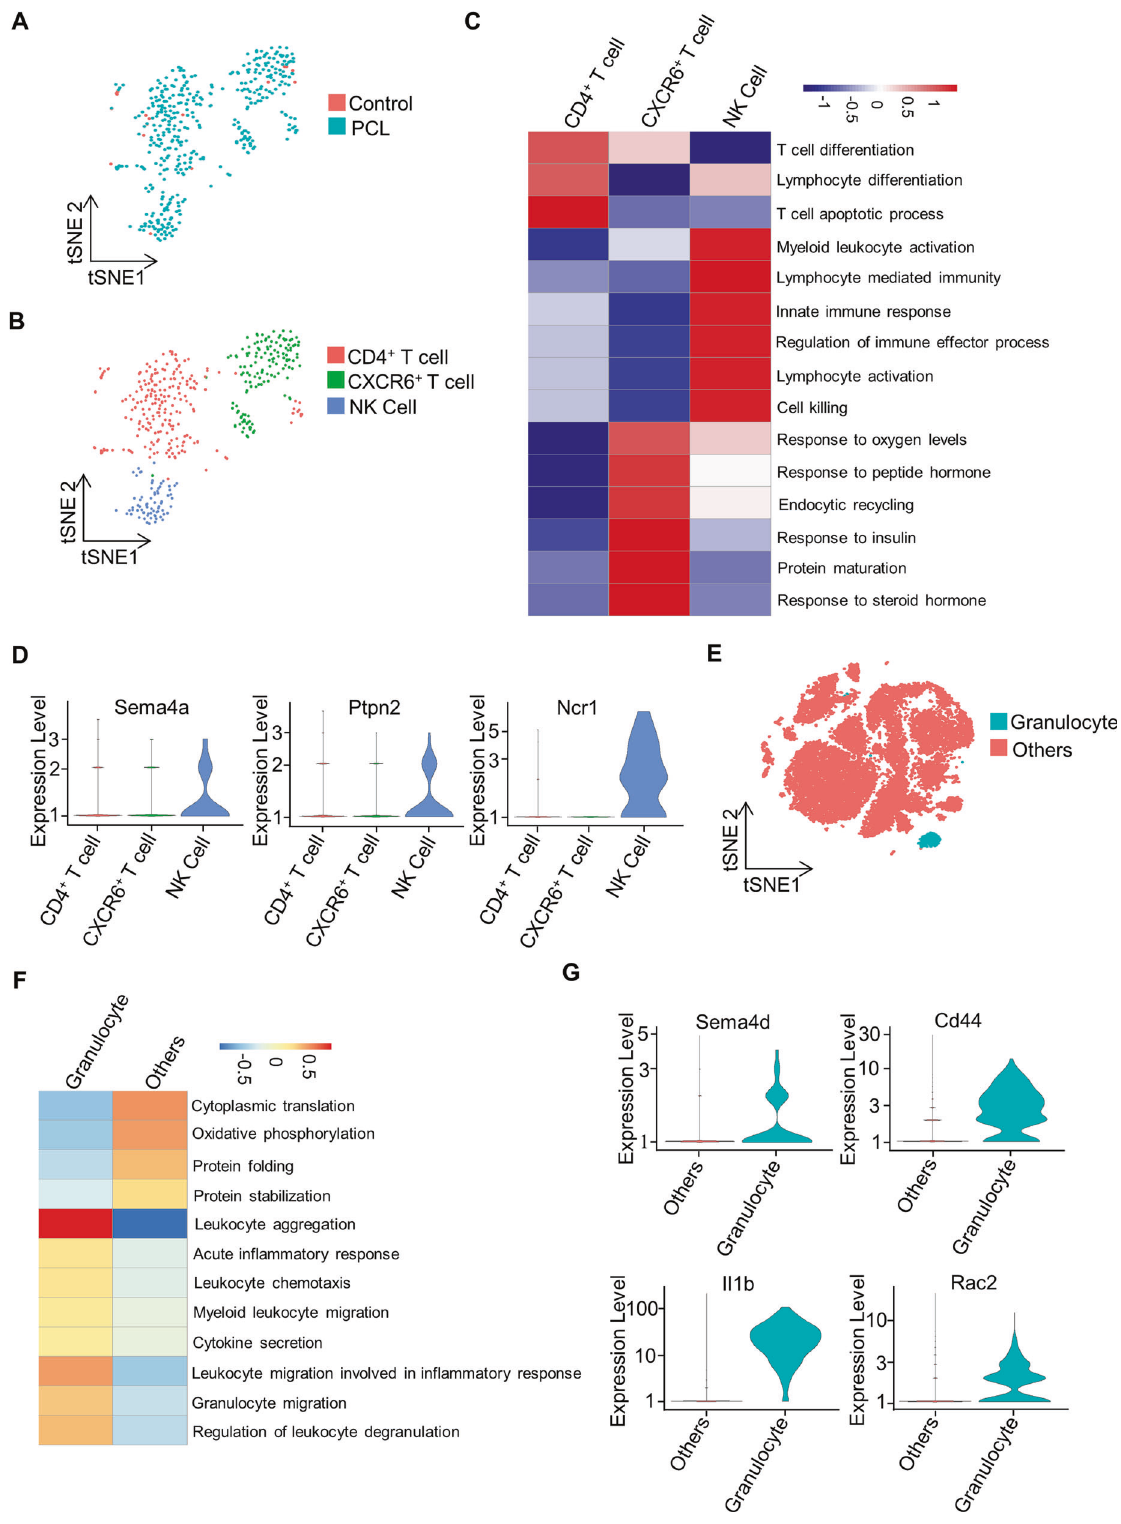
Fig. 5 The in fi ltration of lymphocytes and granulocytes in carotid artery. A T-Distributed Stochastic Neighbor Embedding (t-SNE) plot of lymphocyte subpopulations from the left carotid artery of wild-type mice 7 days after partial carotid ligation (PCL) or without PCL (control). B t-SNE plot of three lymphocyte clusters from LCA with PCL or control, including CD4 + T cells, CXCR6 + T cells, and NK cells. C The heatmap showing differences of biological processes among three distinct lymphocyte populations by GSVA. D The violin plots of the expression of Sema4a, Ptpn2, or Ncr1 in CD4 + T cells, CXCR6 + T cells, or NK cells. E t-SNE plot of populations of granulocyte and others. F The heatmap showing the biological processes of granulocyte population compared to others (without scaled). G The violin plots represent the expression of Sema4d, Cd44, Il1b, or Rac2 in